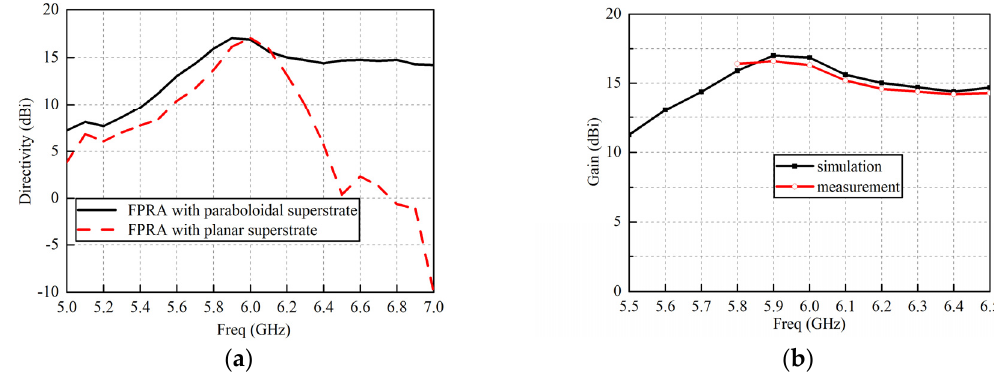
Figure 11a. The 3 ‐ dB gain bandwidths for those two FPRAs are 22.2% (from 5.67 to 7 GHz) and 6%